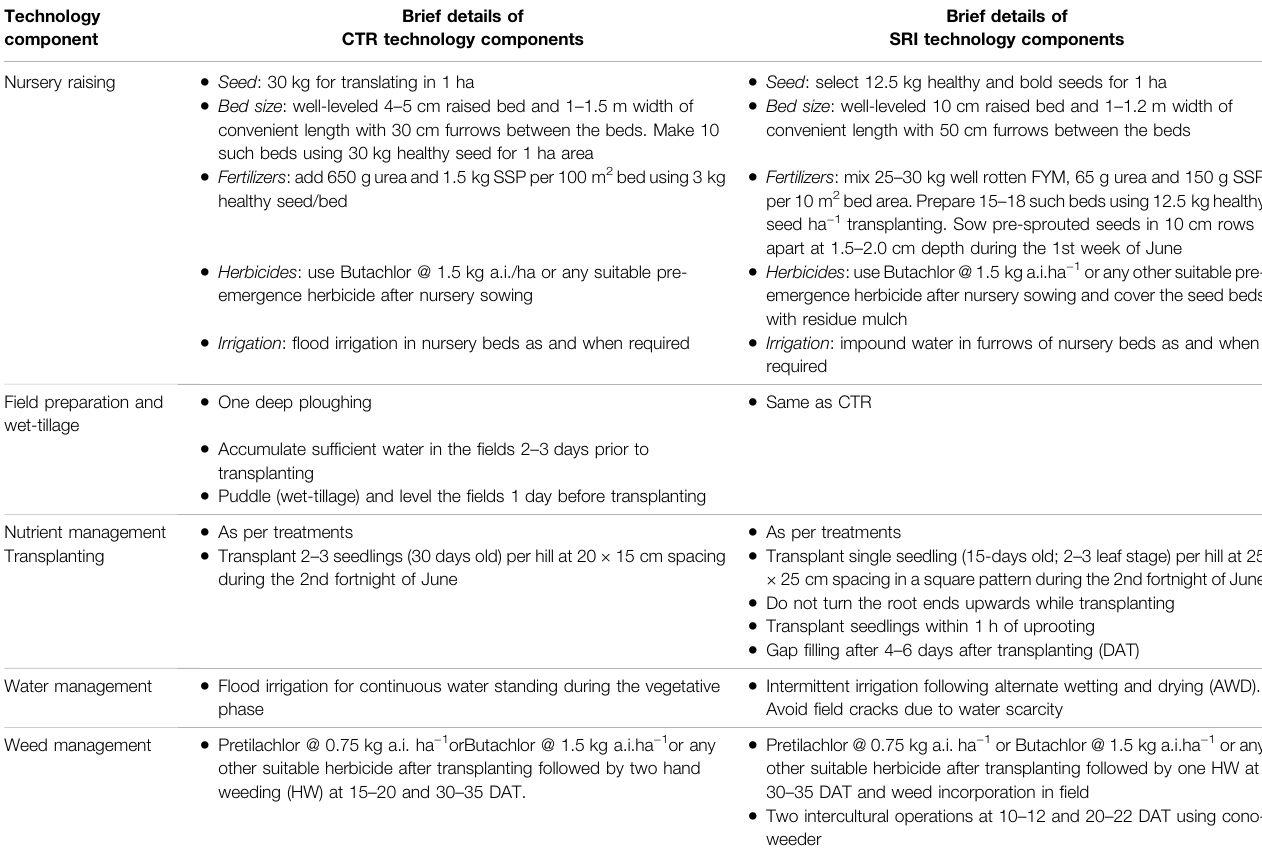
TABLE 2 | Crop management followed under conventionally transplanted rice (CTR) and SRI in the northwestern Himalayas, India. Technology